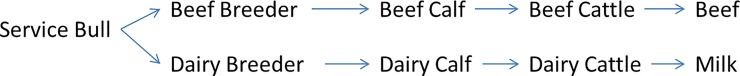
The beef and dairy supply chain.